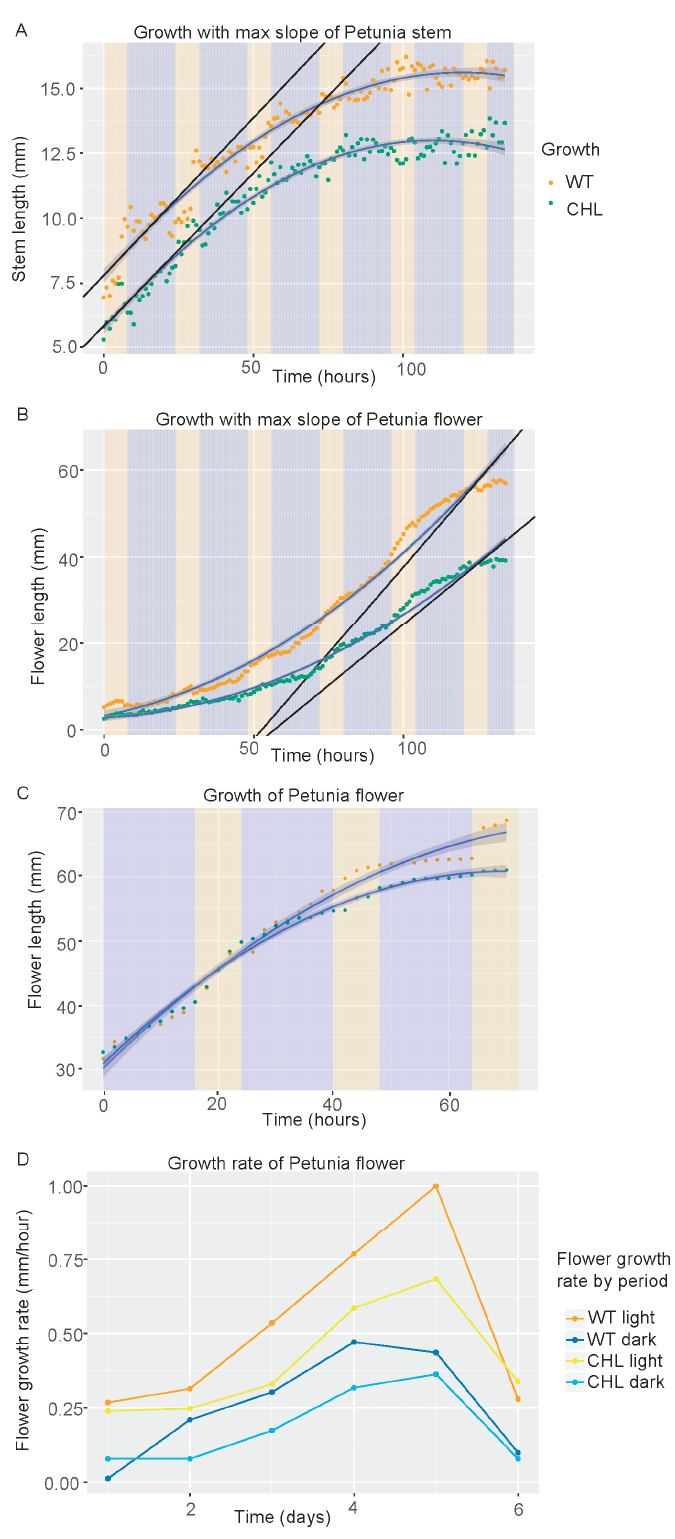
Figure 4. Down regulation of PhCHL a ff ects growth length in stems ( A ) and growth rate in flowers ( B , C ). Graphics show the raw data (points), the adjusted curve and confidence interval (grey shade). Orange line represents WT plants, green line represents RNAi:PhCHL plants. Yellow and blue areas indicated light and dark period, respectively. ( D ) Flower growth rate by period, day versus night in wild-type and RNAi:PhCHL transgenic